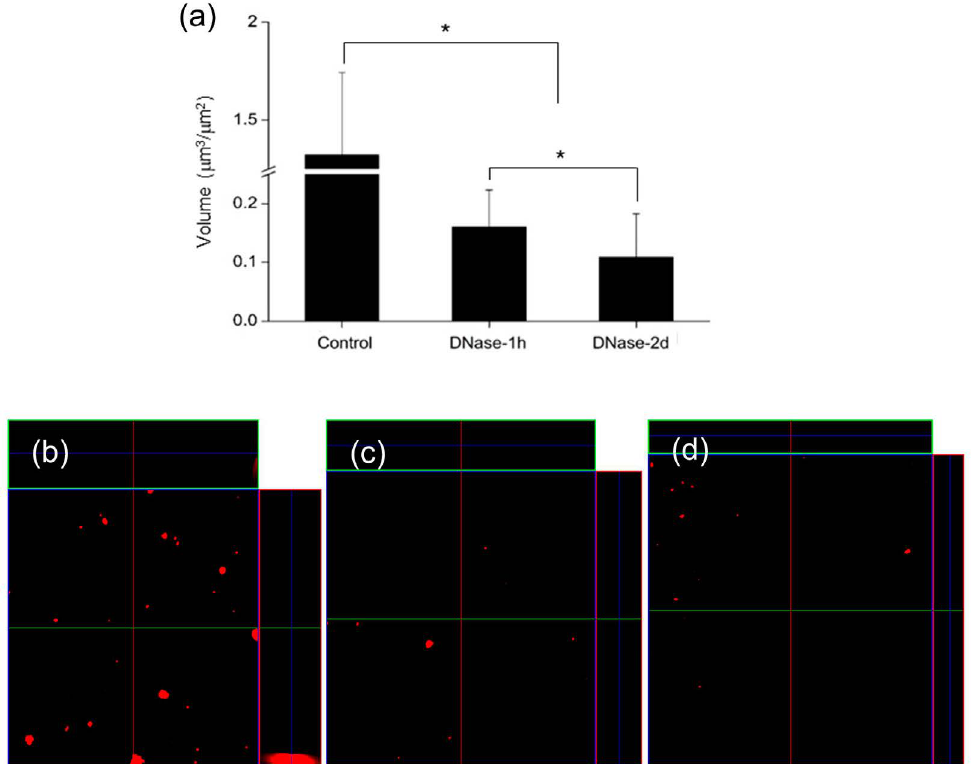
Figure 2- (a) Exopolysaccharides volume in the biofilms. (b-d) Representative CLSM images for measuring exopolysaccharides. Control: cultured only in BHI for 2 days, DNase-1h: treated with DNase for 1 hour after 2-day culture in BHI, and DNase-2d: cultured with DNase for 2 days. *Statistical significance was determined at